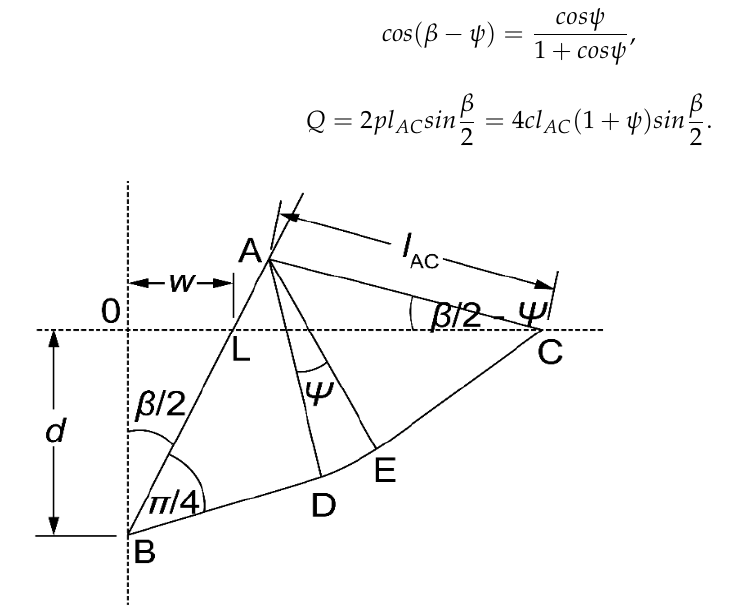
Figure 6. Indentation mechanism of a smooth wedge. The LDFE/CEL technique was applied in the FEA model for the equations and comparisons. The model with eight nodes (EC3D8R) was constructed to model the ground. The Eulerian element was briefly introduced in Section 1. In addition, the symmetry condition was applied, and the parameters of the wedge were restrained in all directions except for the z-direction so that displacement could occur only in that direction. The wedge had a shape with angles of 60 ◦ and 90 ◦ ( β /2), which could penetrate to depths of 0.4 m and 0.3 m, respectively. The topography of the entire analysis model is illustrated in Figure 7.